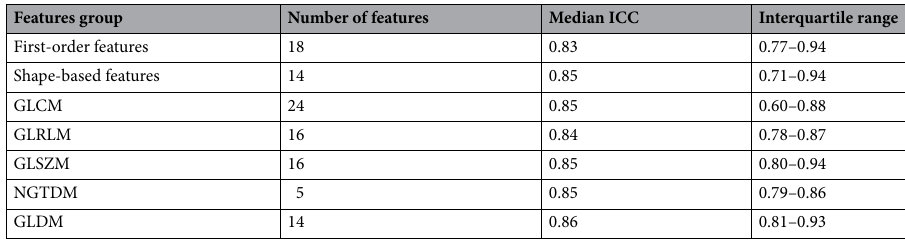
Table 3. Median and interquartile range for the intraclass correlation coefficient (ICC) values per feature group. GLCM gray-level co-occurrence matrix, GLRLM gray-level run length matrix, GLSZM gray-level size zone matrix, NGTDM neighboring gray tone difference matrix, GLDM gray-level dependence